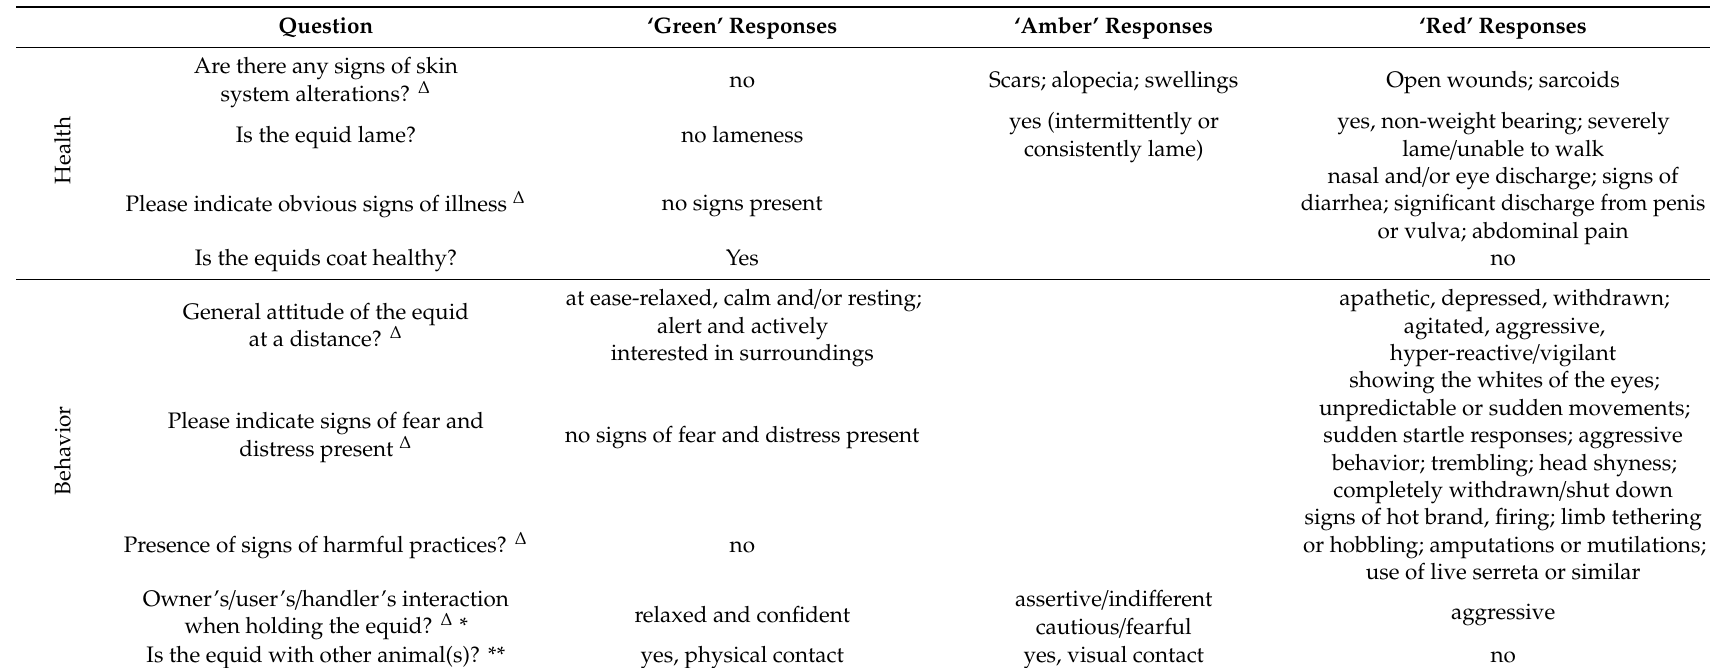
Table 1. Questions selected for the health and behavior